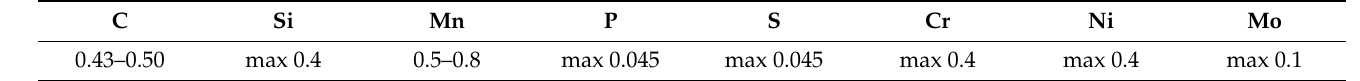
Table 1. Chemical composition of the C45 machined material (wt.%).